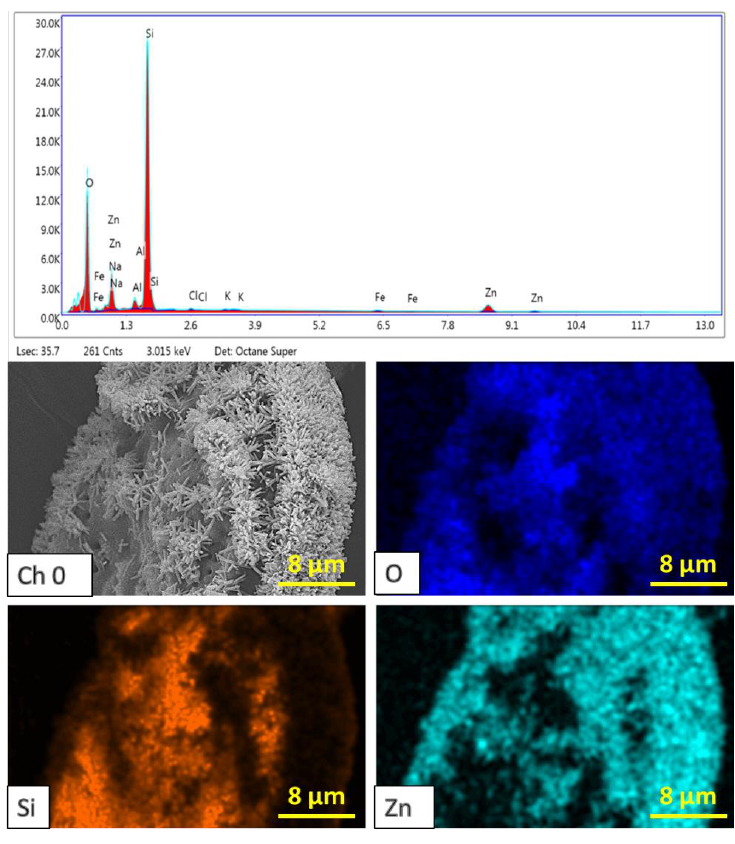
Figure 3. EDS and corresponding elemental mapping of 10% ZnO@diatomite.